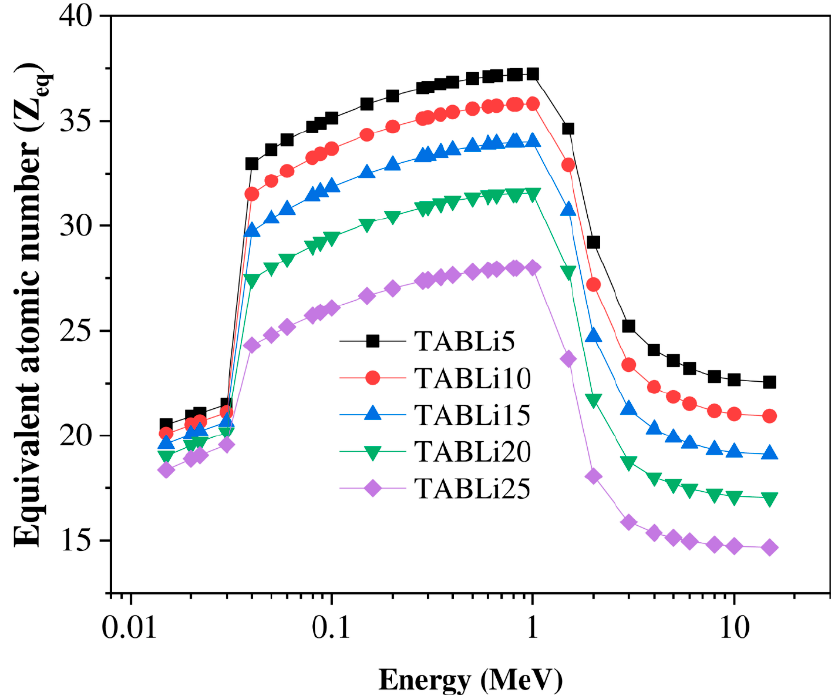
Figure 15. The equivalent atomic number as a function of the energy.